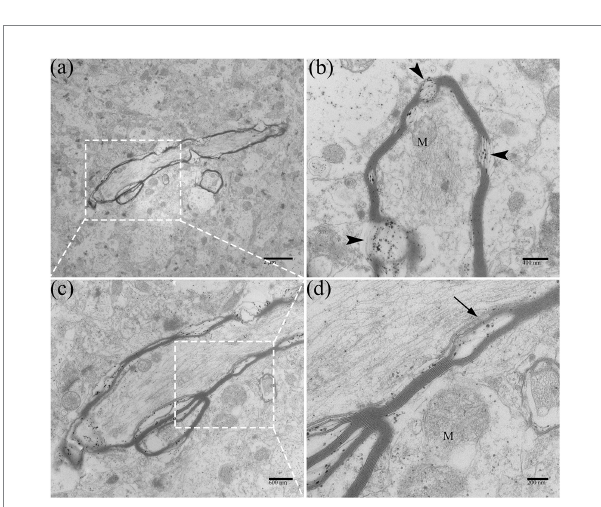
FIGURE 9 Ultrastructural pathological changes of nerve fibers in DTMUV- infected adult duck brain. (A) Myelinated nerve fibers in low- magnification. (B) The myelin sheath of myelinated nerve fibers was dissolved (arrowhead). (C,D) The myelin sheath of myelinated nerve fibers was split (arrow). Mitochondria within myelinated nerve fibers were also swelled and ruptured. M,